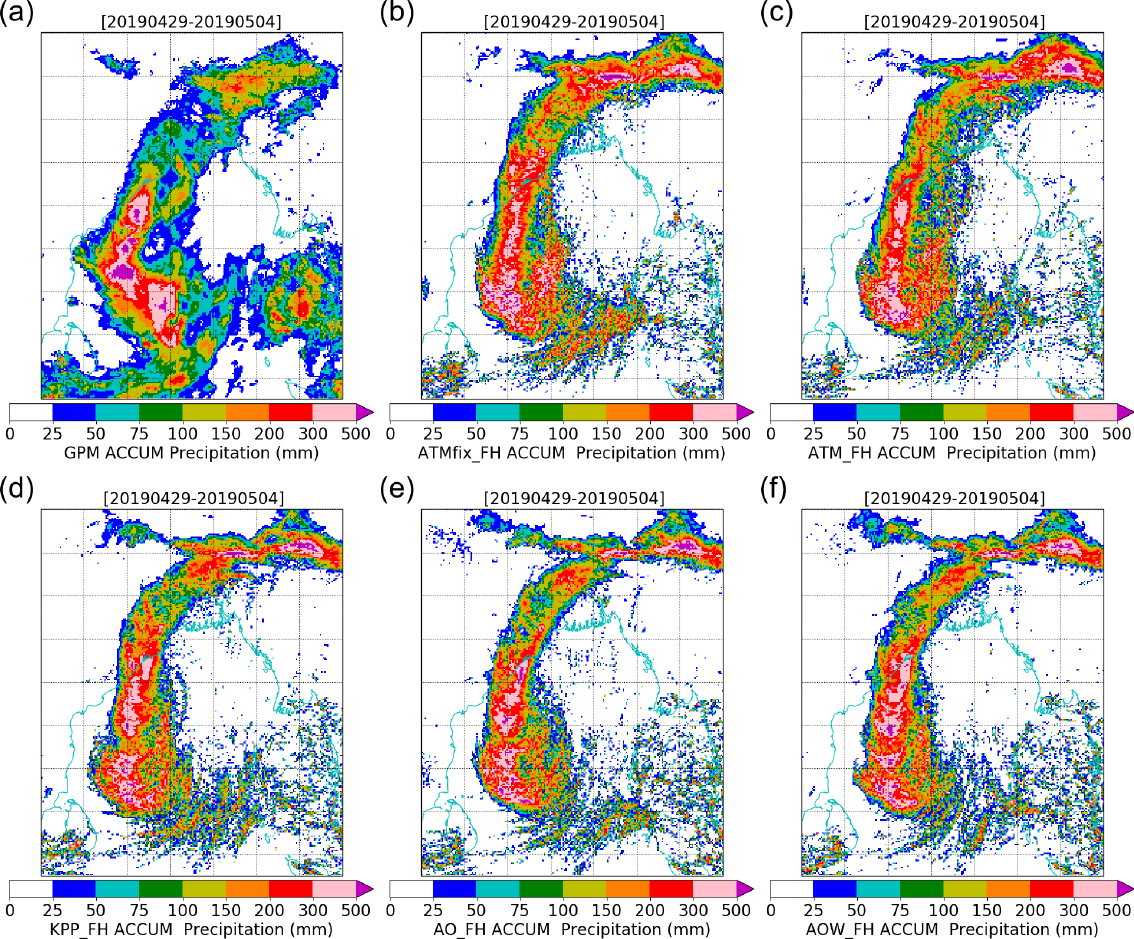
Figure 11. 7d precipitation accumulation during Fani case study over Bay of Bengal sub-domain region (a) observed by GPM (NASA Global Precipitation Measurement) and simulated by (b) ATMfix_FH, (c) ATM_FH, (d) KPP_FH, (e) AO_FH and (f) AOW_FH. All simulated data are interpolated to the GPM resolution prior to computing accumulations. See Fig. S4 for corresponding figure for simulations without frictional heating